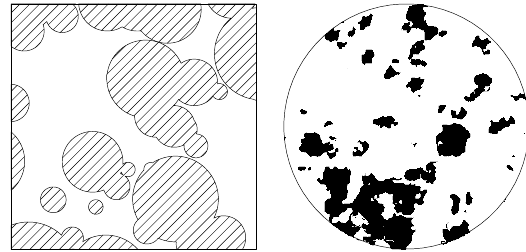
Figure 1: Example realisations of RACS. Left: A Boolean model (Stoyan and Mecke, 2005) observed in a rectangular region; hatched regions denote locations inside the random set. Right: A map of tree canopy which can be represented as a realisation of a RACS. This is also an example of the observations used in Section